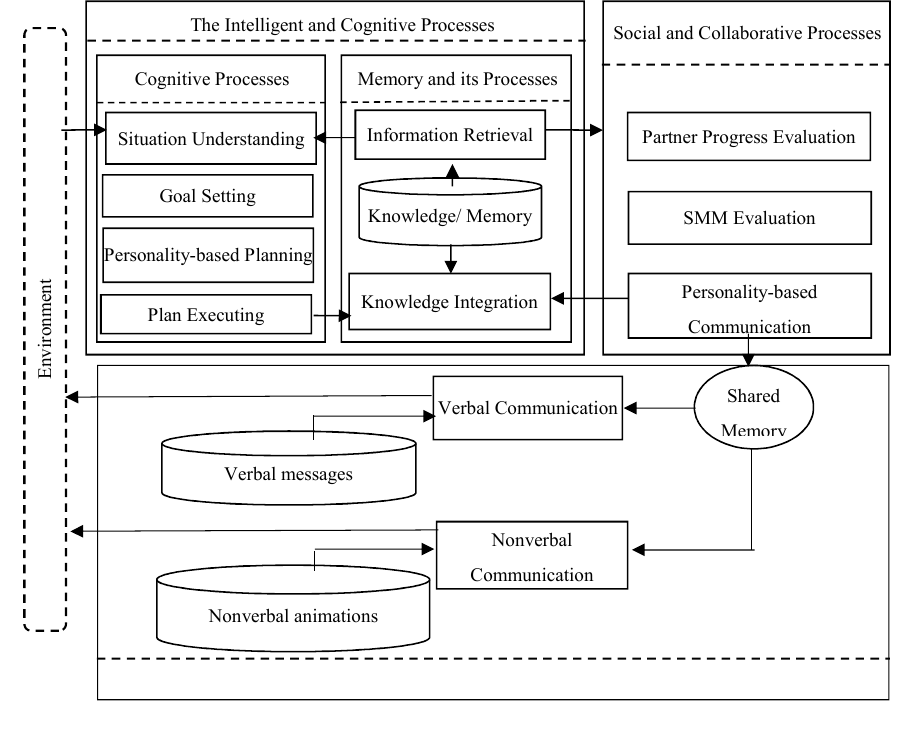
Figure 3. Human–agent communication model (HAT-CoM).